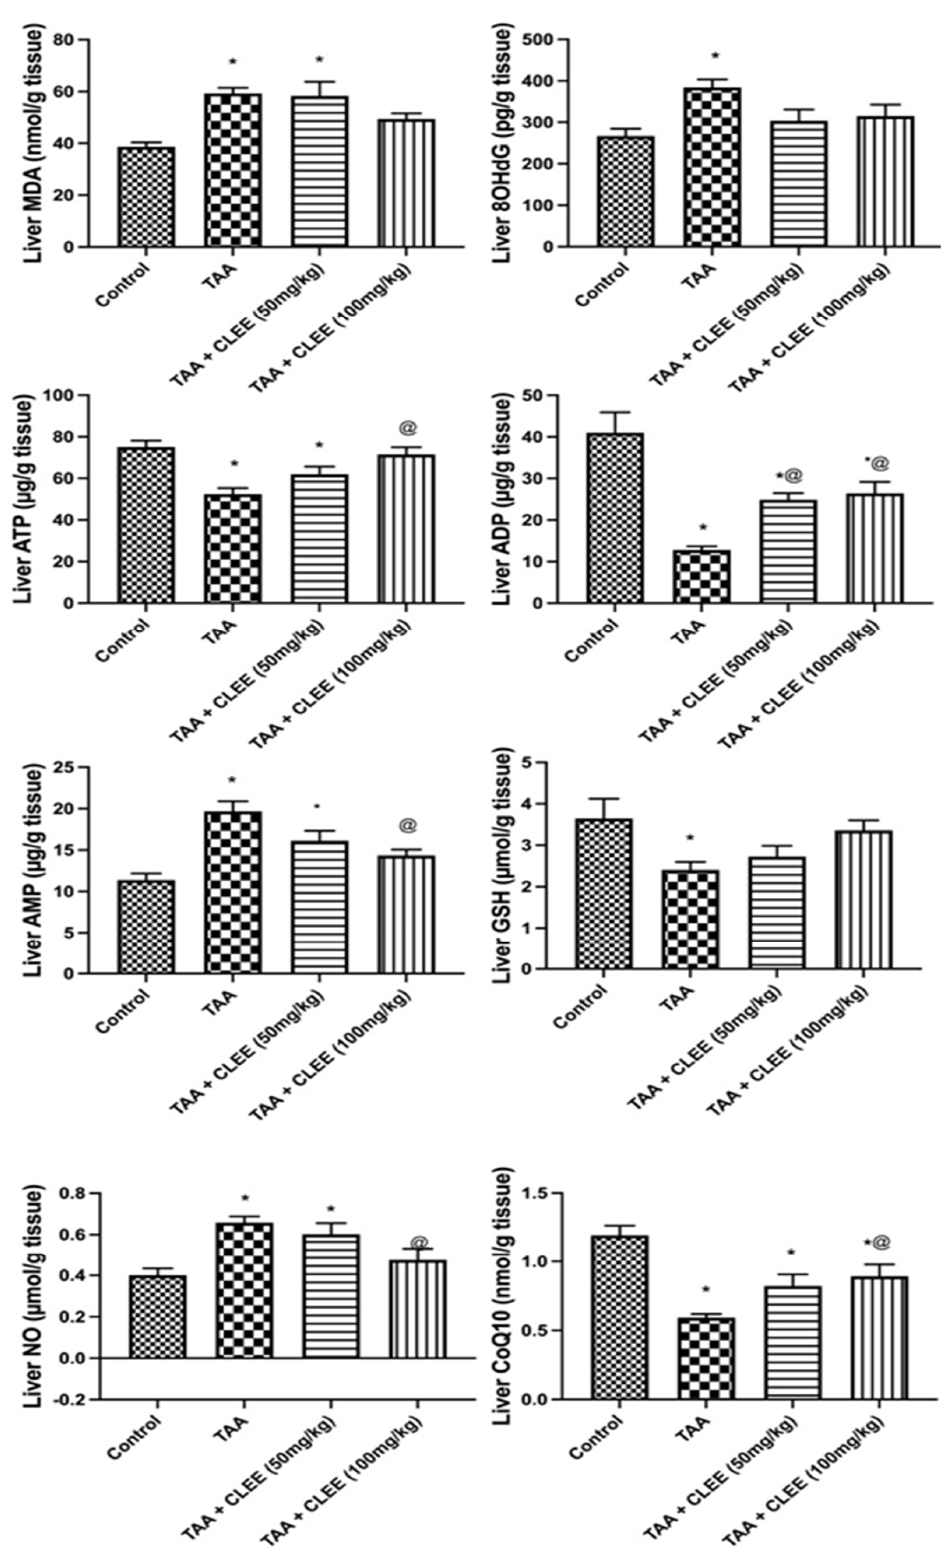
Figure 6. Effect of C. laevigatus EtOH extract (CLEE) on hepatic oxidative stress and energy parameters of rats intoxicated by TAA. Each value represents the mean of six animals ± SE. Statistical analysis was performed using one-way ANOVA followed by the Tukey-Kramer multiple comparisons test. (* vs. control group, and @ vs. TAA group) at p <